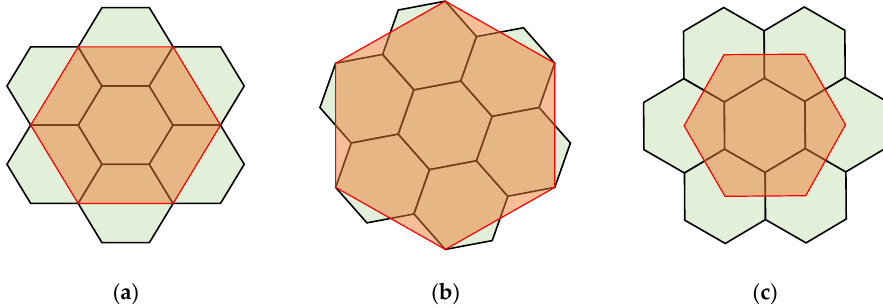
Figure 20. Hexagonal grids with different subdivision structures. ( a ) Aperture 4 hexagonal grid; ( b ) Aperture 7 hexagonal grid; ( c ) Aperture 3 hexagonal grid.